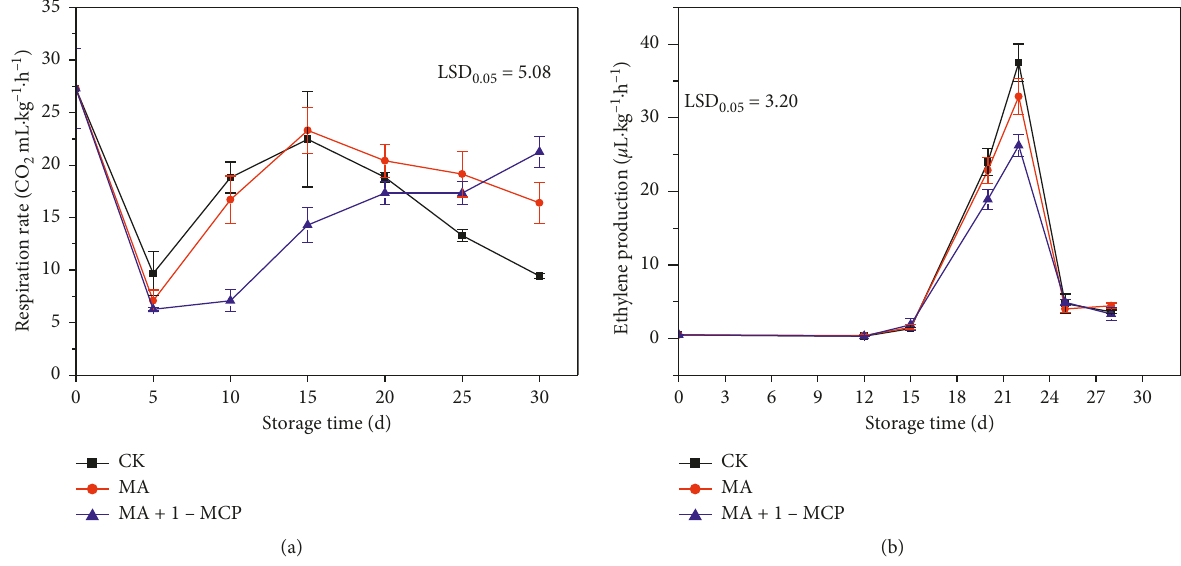
Figure 4: Effects of MA+1-MCP and MA treatment on respiration rate (a) and ethylene production rate (b) in fig fruit stored at − 1 ° C for 30 days. Data represent the mean value of five measurements ± the standard errors. LSDs represent significant differences at the 0.05 level.